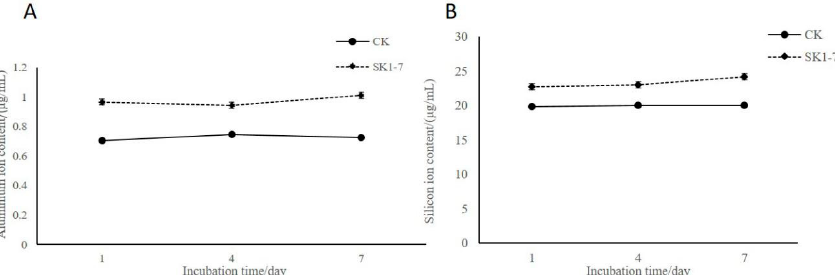
Figure 2. The aluminum and silicon ion contents in potassium solution fermentation broth after B. aryabhattai SK1-7 inoculation. CK: added with LB medium and water. SK1-7: inoculated with strain B. aryabhatta. ( A ) Changes in the aluminium ion concentration of potassium-solubilizing fermentation medium after 7 days of cultivation. ( B ) Changes in the silicon ion concentration of potassium-solubilizing fermentation medium after 7 days of cultivation. The error bars indicate standard errors.